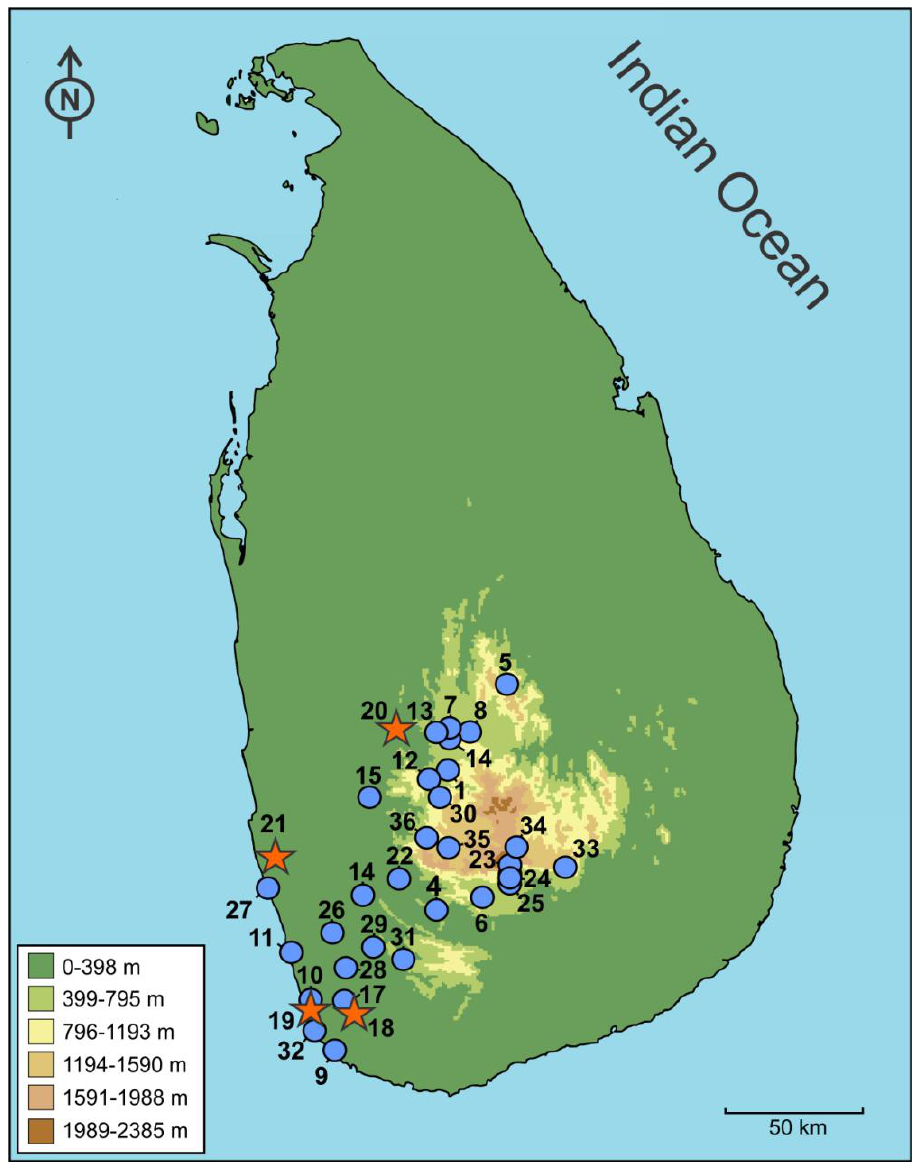
Figure 1: Updated distribution map of Hemiphyllodactylus typus in Sri Lanka based on published (blue spots) and new records in the present study (orange stars). See Table 1 for other